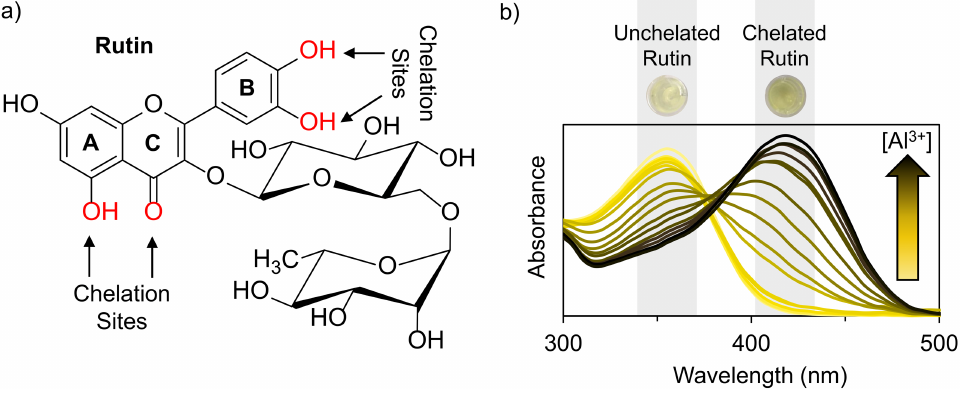
Figure 1 Rutin chelation of aluminum forms colored complexes. The metal chelation capacity of rutin